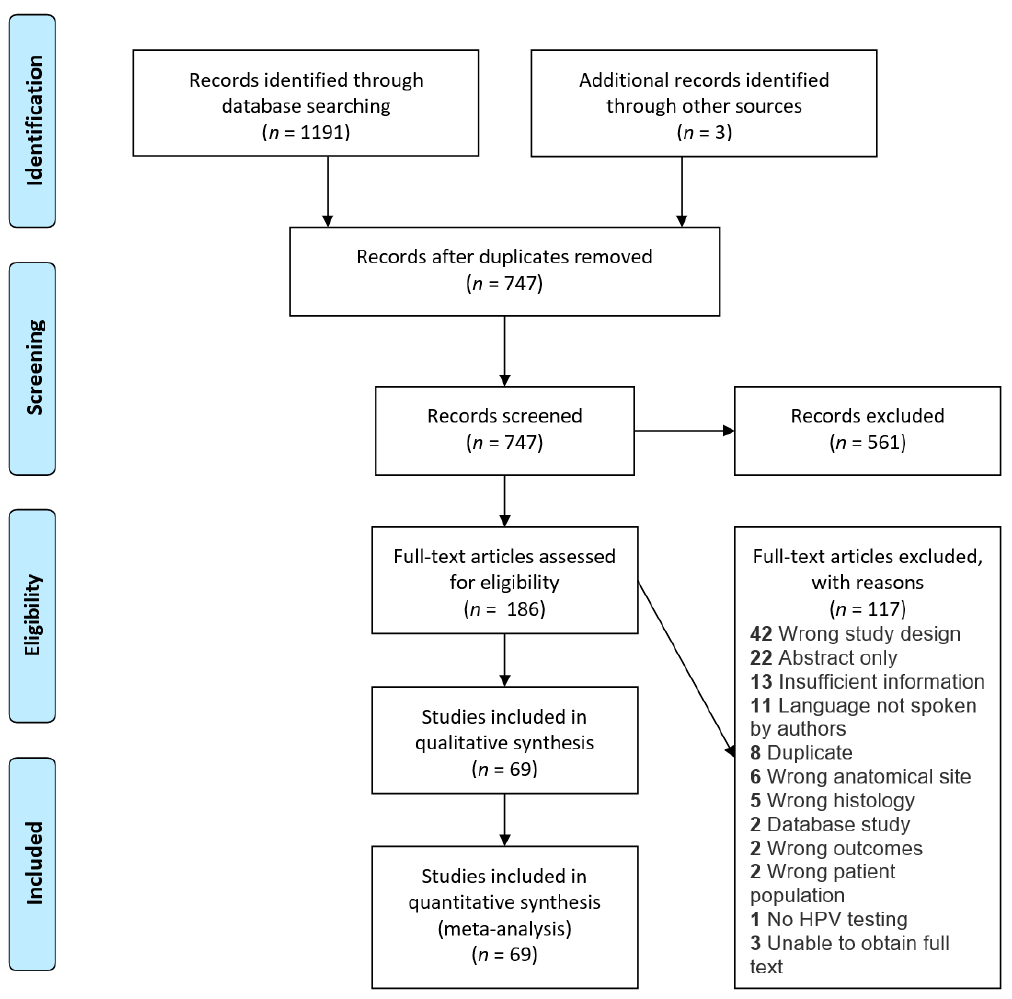
Figure 1. Preferred Reporting Items for Systematic Reviews and Meta-Analyses (PRISMA) flowchart depicting the study selection process.